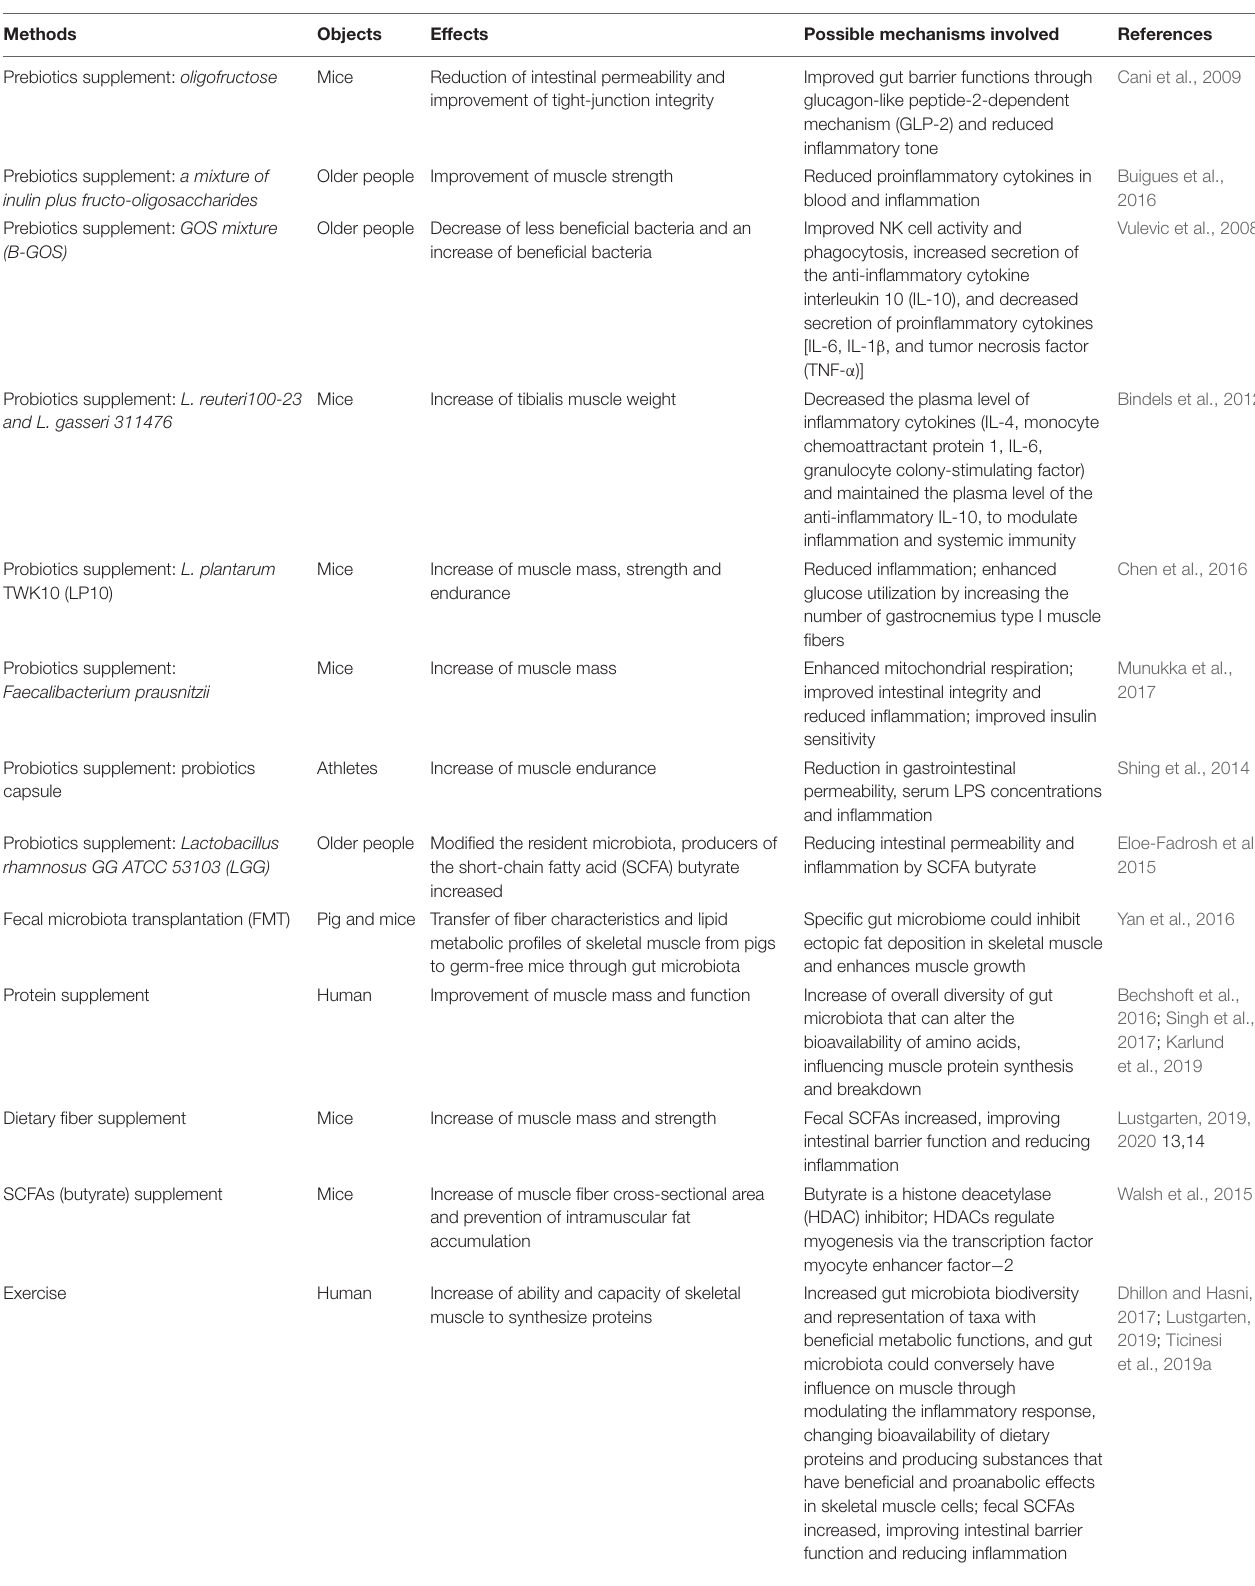
TABLE 1 | The balance effects of different nutrients supplements and exercise on the gut and/or skeletal muscle health of animal models or